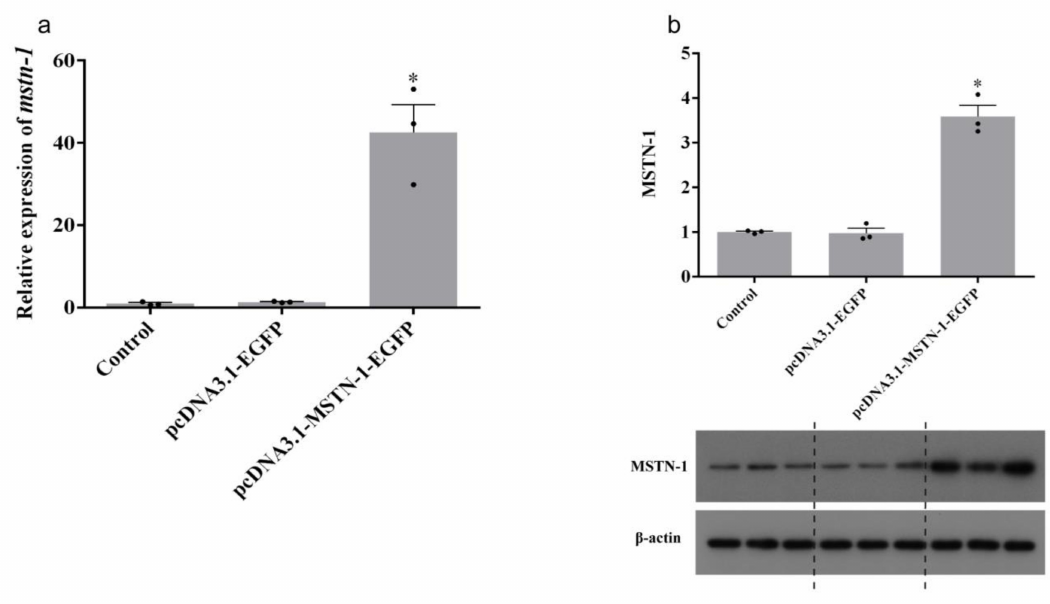
Figure 6. Relative expression levels of the mRNA ( a ) and protein ( b ) of MSTN-1 in primary cultured muscle cells treated with pcDNA3.1-MSTN-1-EGFP plasmid. Results are represented as mean ± SE ( n = 3). * means significantly di ff erent compared with control ( p <